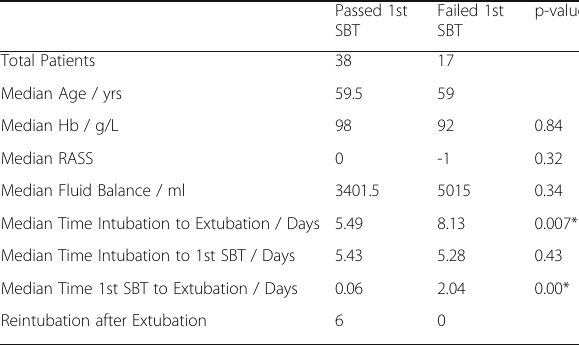
Table 1 (abstract 0149). Patient